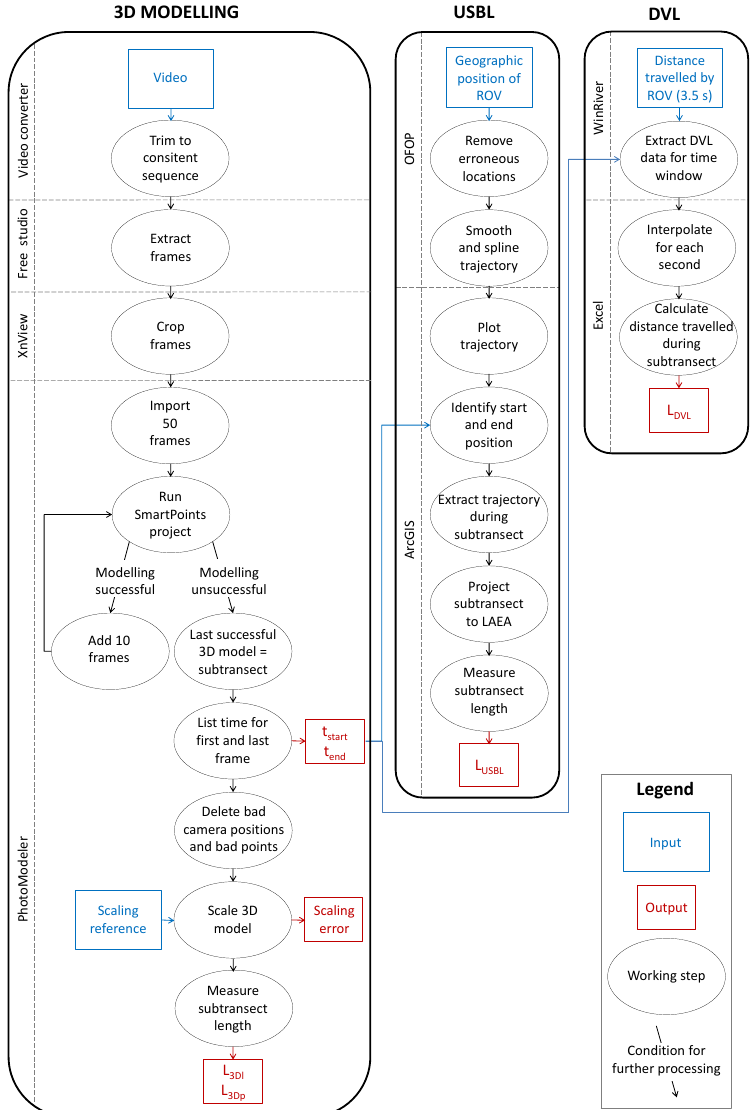
Fig. 1. Workflow for the determination of subtransect length through 3-D modelling, USBL navigation and DVL bottom tracking.